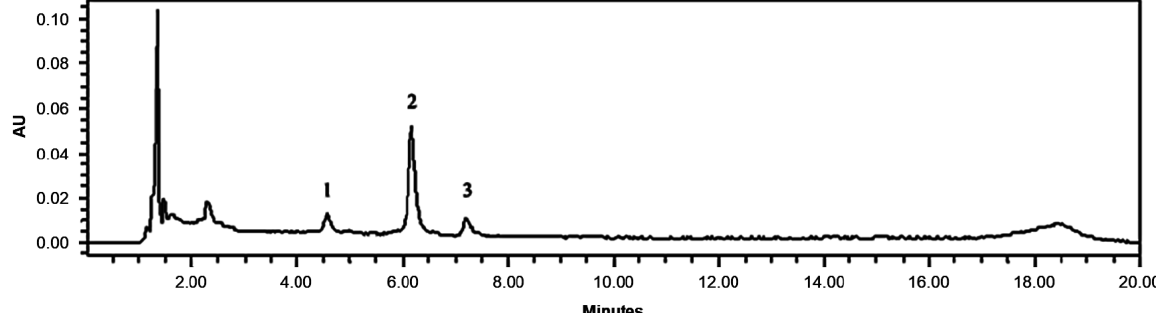
Figure 1. Chromatogram profile showing major anthocyanins in jabuticaba wine. ( 1 ) delphinidin-3- O -glucoside; (2) cyanidin-3- O -glucoside; and (3) unknown